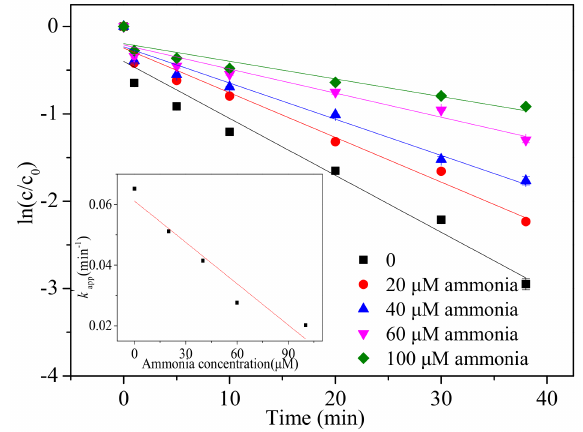
Figure 5. E ff ect of the ammonia concentration on AML degradation by the UV / chlorine process ([AML] 0 = 10 µ M, [chlorine] 0 = 30 µ M, UV intensity = 500 µ W · cm − 2 , pH = 7).